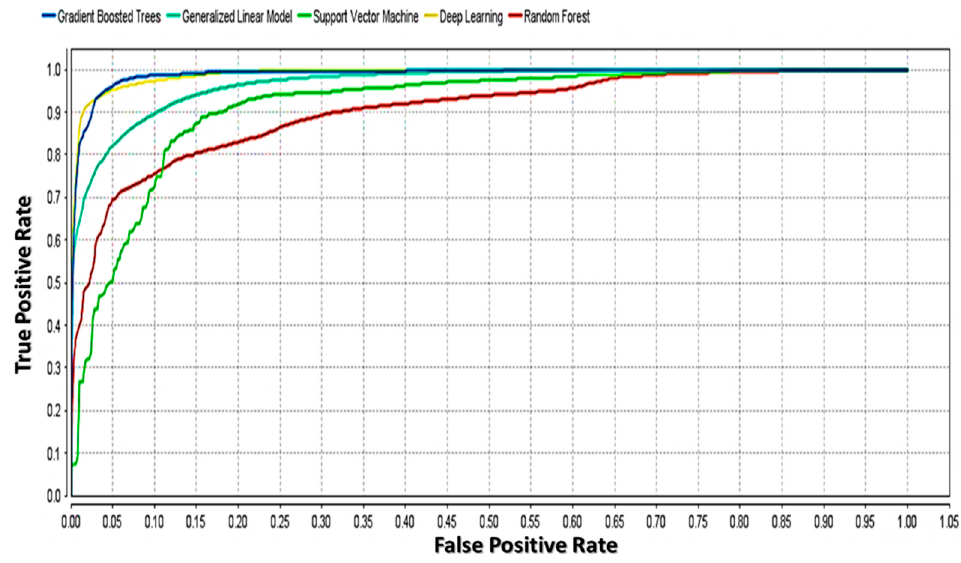
Figure 9. The area under the receiver operating characteristics (ROC) curve for the tested classifiers.